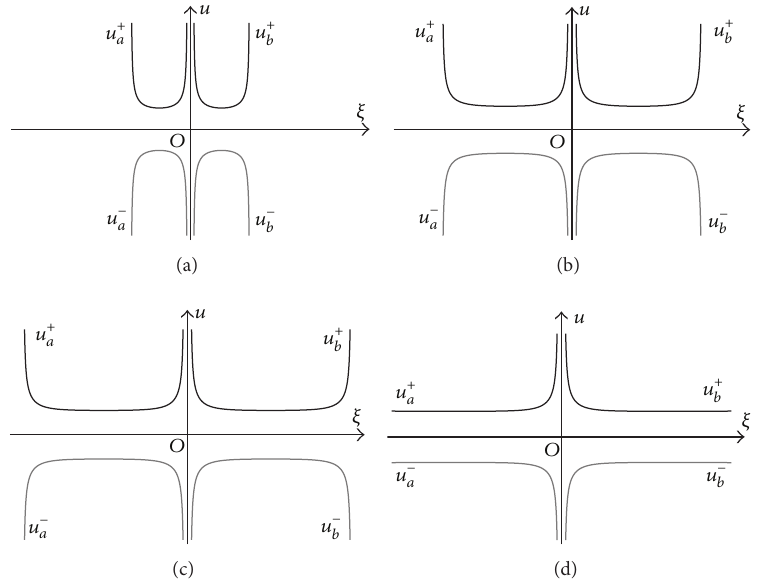
Figure 6: Four 2-blow-up waves become four 1-blow-up waves. The varying process for the figures of 𝑢 ± 𝑎 and 𝑢 ± 𝑏 when 𝜆 < 0 , 𝜆 ̸= −√𝛽 2 1 − 4𝛼 1 , (𝑎,𝑏) ∈ 𝐴 𝑏 → −(5𝑎 2 /48𝑐) + 0 , where 𝜆 = −50 , 𝛾 = 𝛿 = 𝑐 = 𝑎 = 1 , and (a) 𝑏 = −(5𝑎 2 /48𝑐) + 10 −2 , (b) 𝑏 = −(5𝑎 2 /48𝑐) + 10 −4 , 2 , and (c) 𝑏 = −(5𝑎 2 /48𝑐) + 10 −5 , and (d) 𝑏 = −(5𝑎 2 /48𝑐) + 10 −7 .